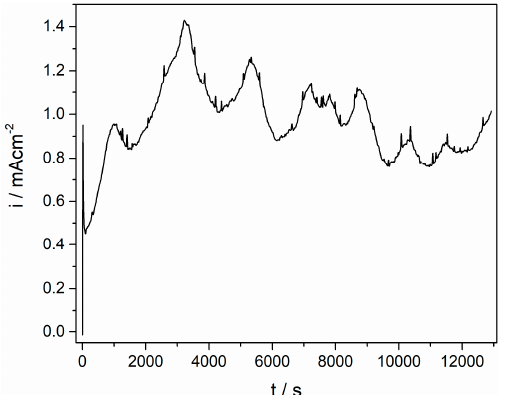
Figure 4. Anodic dissolution of the Ti working electrode at 0.500 V for 3.6 h in the equimolar AlCl 3 –NaCl melt at T = 200 °C.